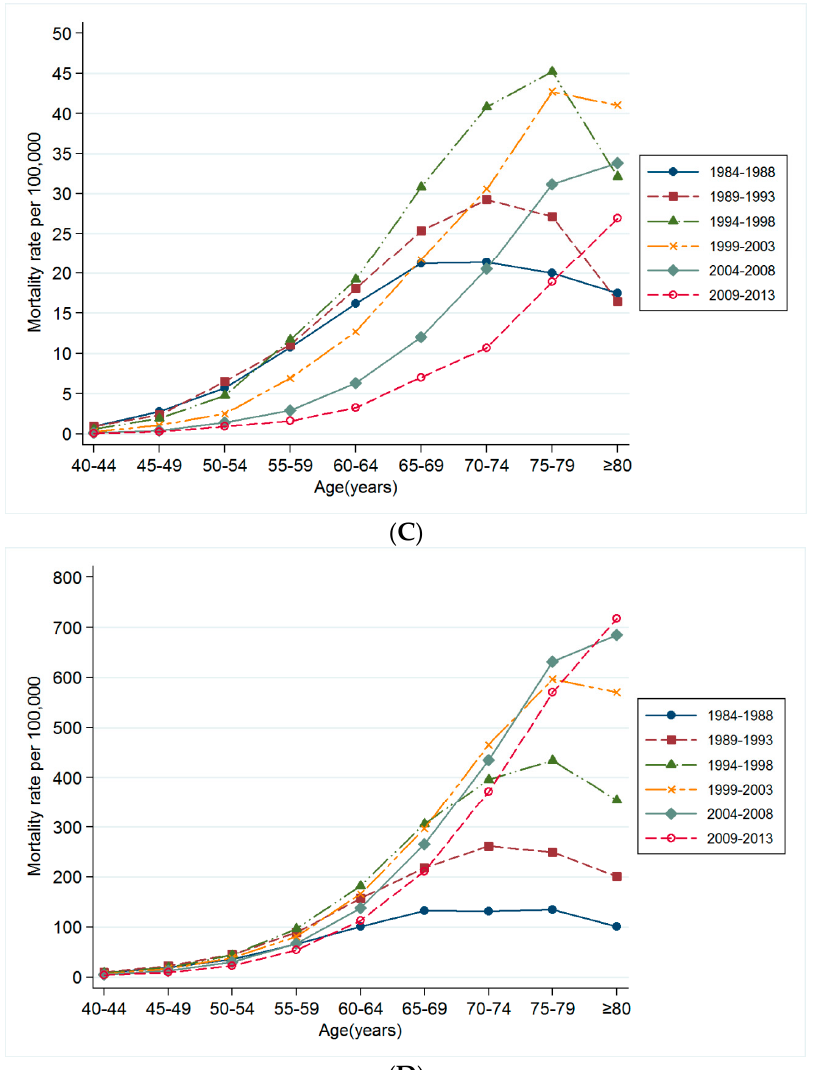
Figure 2. ( A ) Change in age-specific mortality rate for oropharyngeal cancer by time period; ( B ) Change in age-specific mortality rate for esophageal cancer by time period; ( C ) Change in age-specific mortality rate for laryngeal cancer by time period; ( D ) Change in age-specific mortality rate for lung cancer by time period.